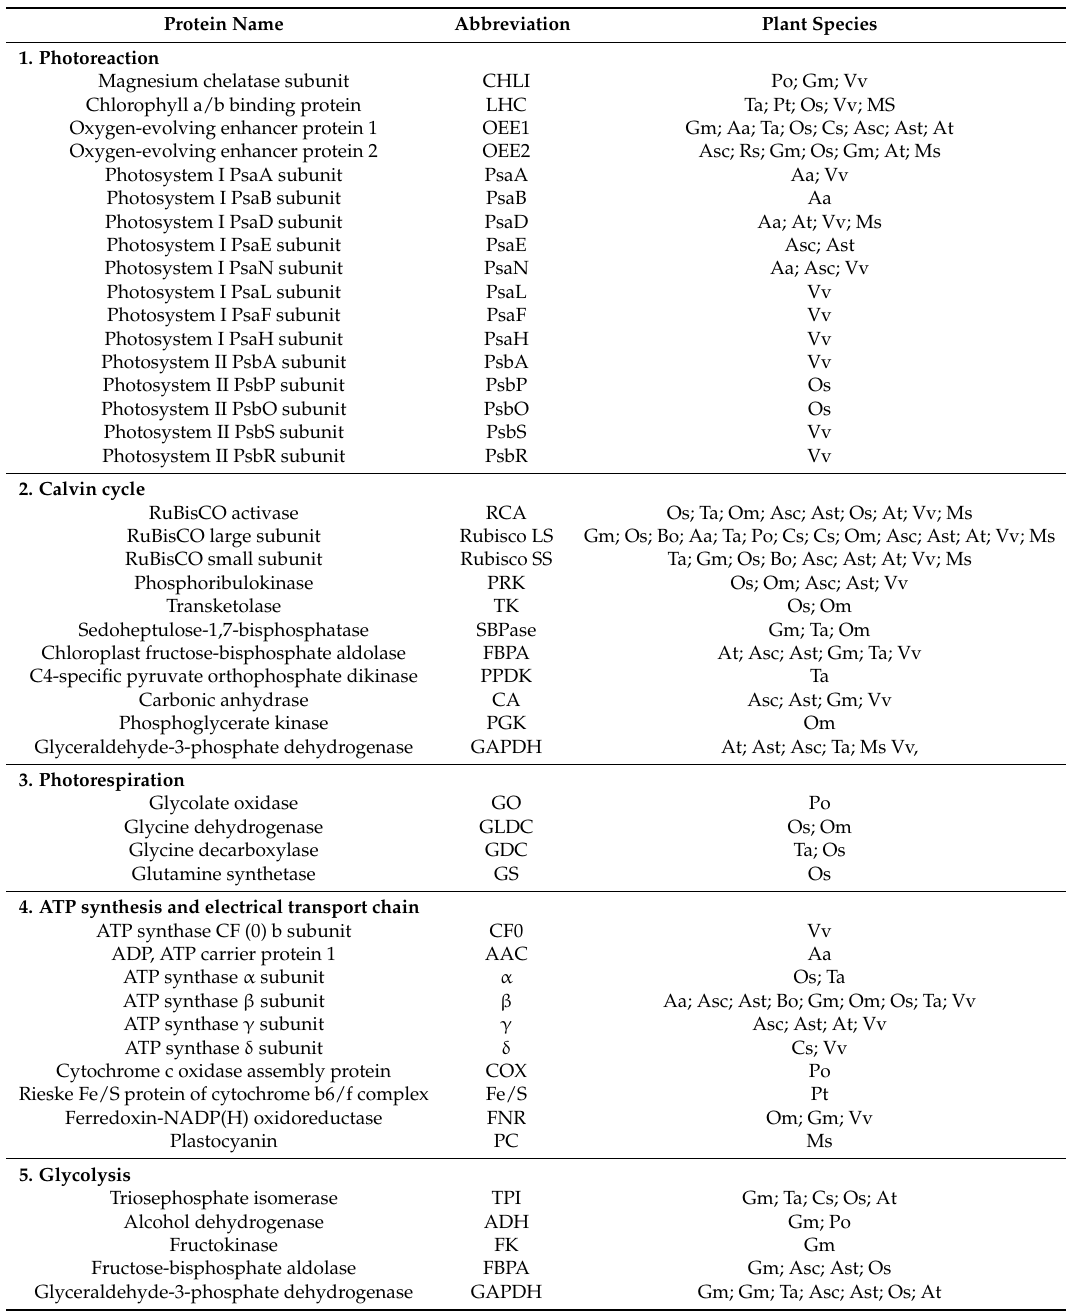
Table 2. Heat stress-responsive proteins involved in photosynthesis, carbon metabolism and signaling identified in leaves by proteomics